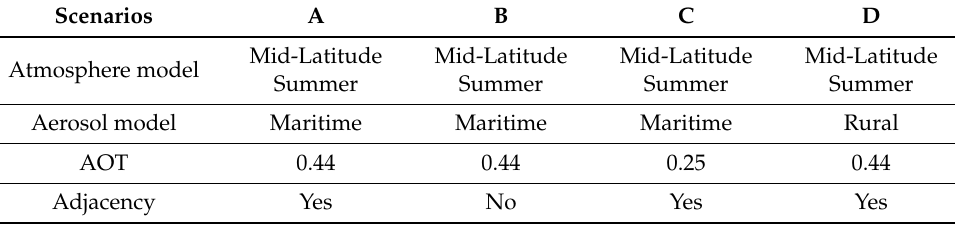
Table 1. Scenarios considered for the comparison between satellite and field